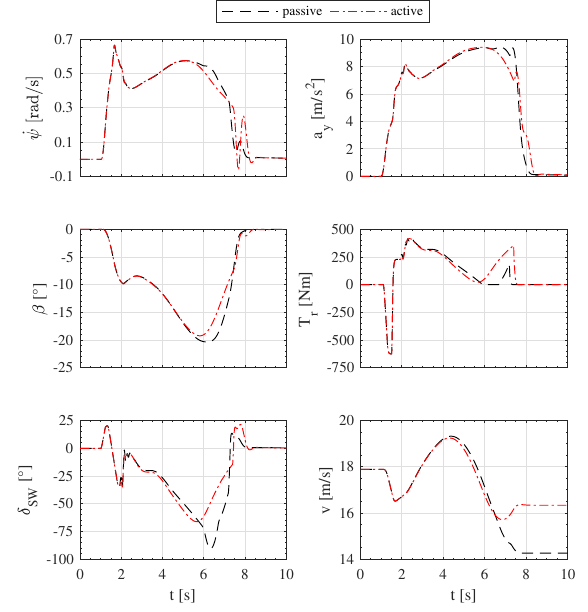
Figure 10. U-turn, highly skilled driver, dynamics quantities.